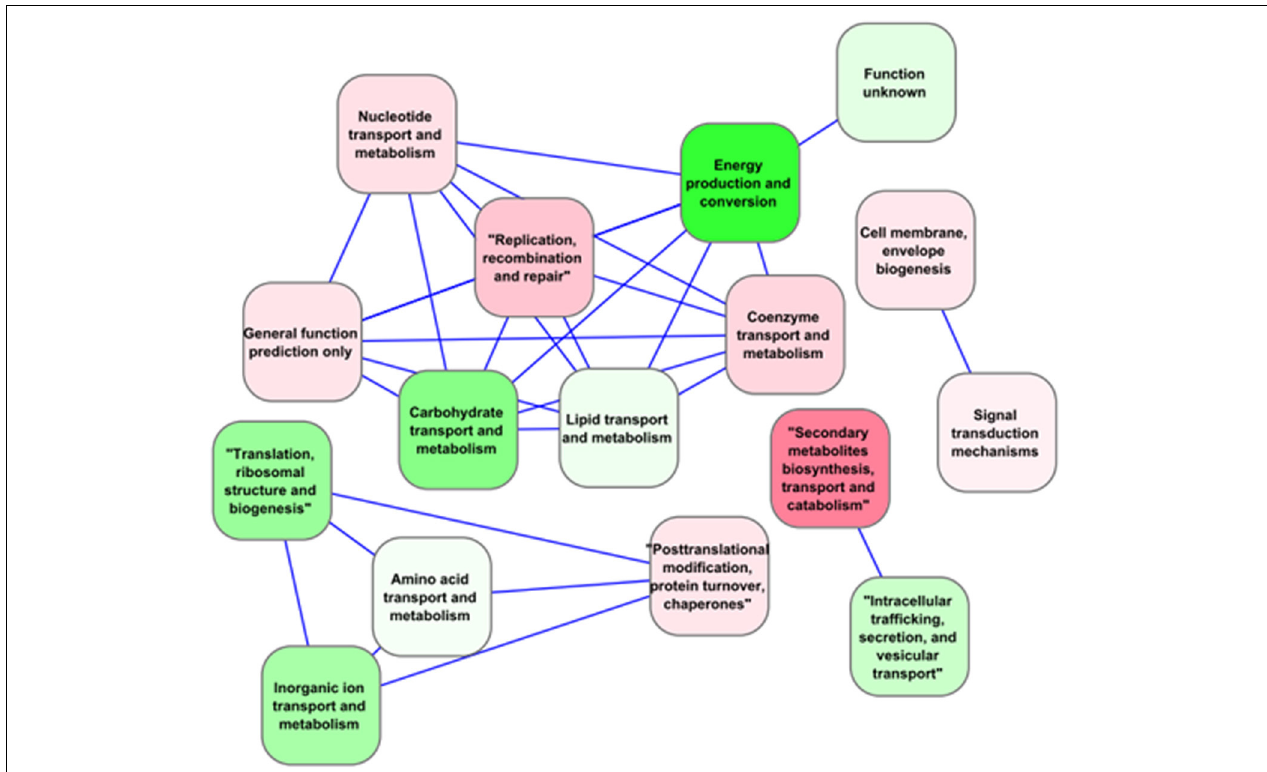
FIGURE 3 | Correlation network for functional categories (as defined by Falkowski, 2012) based on the expression of “core” genes in Synechocystis sp. PCC 6803 under multiple environmental conditions extracted from CyanoEXpress. Nodes represent Gene Ontology (GO)